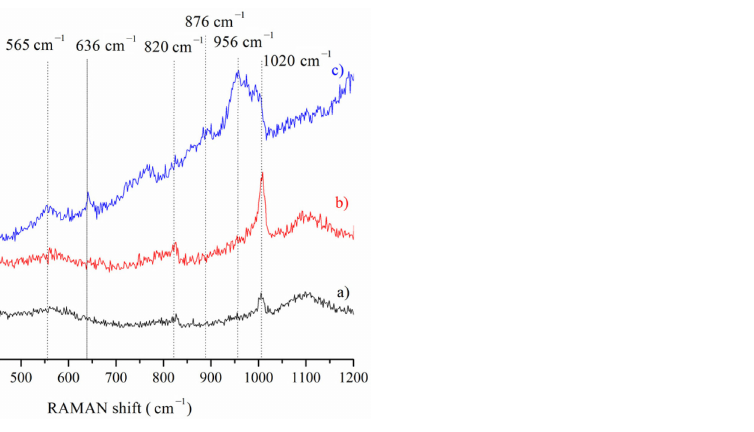
Figure 3. Raman spectra of MIL-100(Cr) ( a ), PW12@MIL-100(Cr) ( b ) and PW4@MIL-100(Cr) ( c